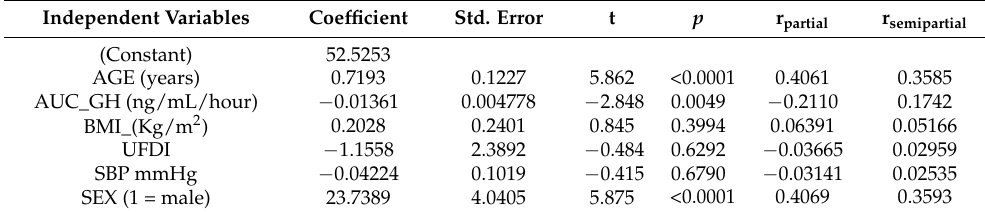
Table 7. Multiple linear regression